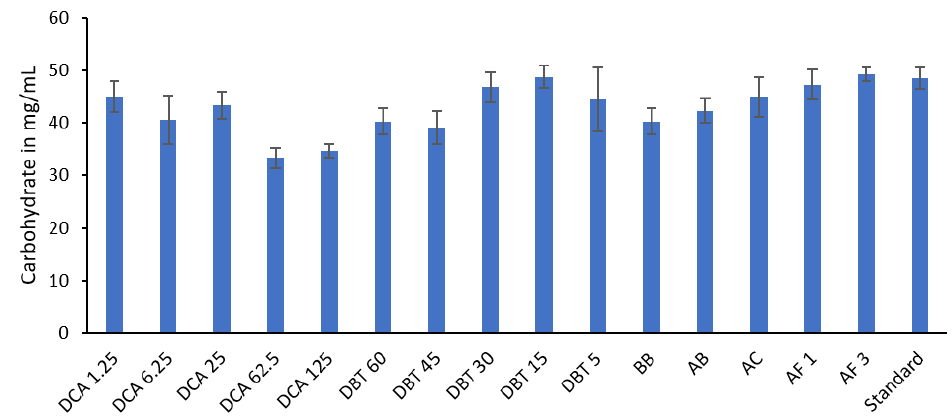
Figure 2. Total carbohydrates in Aronia berry-infused beer as glucose equivalents.